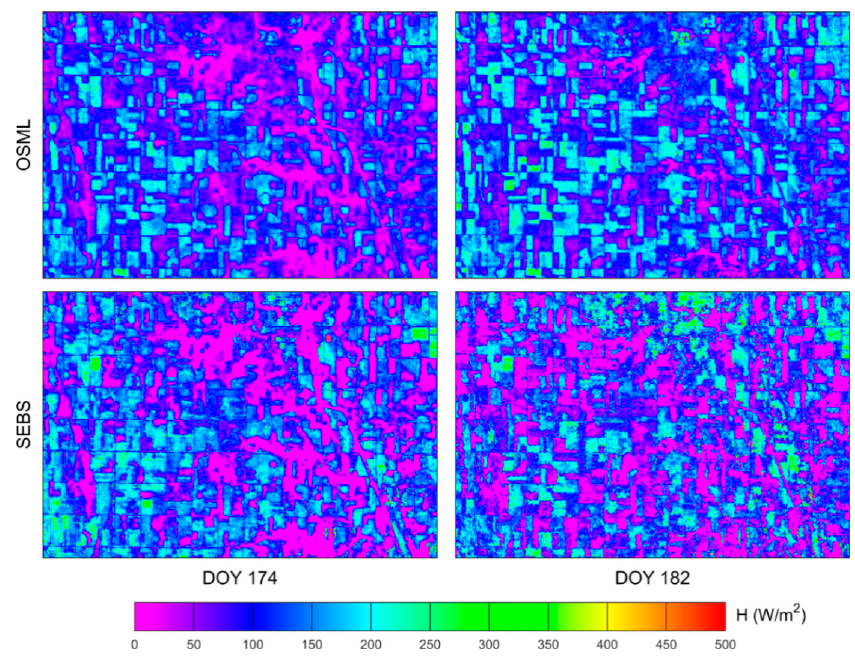
Figure 7. The spatial distribution of H estimated using OSML and SEBS from Landsat-based retrievals on DOY 174 and 182.